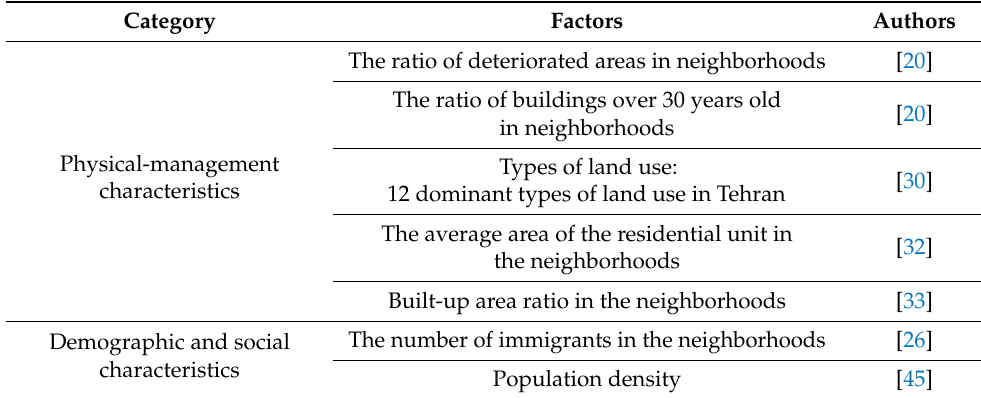
Table 3. Water consumption indicators (WCI).